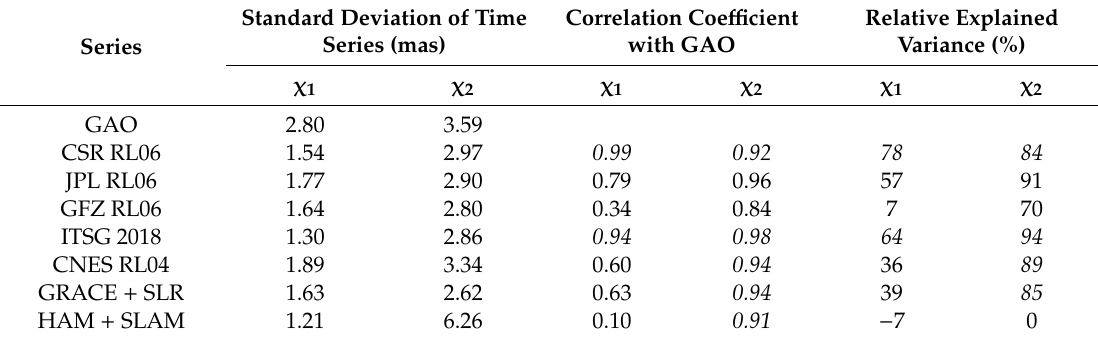
Figure 11. Changes with the periods of 1000–4000 ( a , b ), 450–1000 ( c , d ), 100–450 ( e , f ), and 60–100 ( g , h ) days in χ 1 and χ 2 components of GAO, GSMAM, GRACE + SLR, and HAM + SLAM. Table 6. Standard deviation of GSMAM, GAO, GRACE + SLR, and HAM + SLAM time series, correlation coe ffi cients with GAO, and percentage of variance in GAO explained by GSMAM, GRACE + SLR and HAM + SLAM. Oscillations with periods 1000–3000 days are considered. The critical value of the correlation coe ffi cient for 9 independent points and a confidence level of 0.95 is equal to 0.58. The standard error of the di ff erence between two correlation coe ffi cients for the 9 independent points is equal to 0.58. The highest values of correlations and relative explained variances are